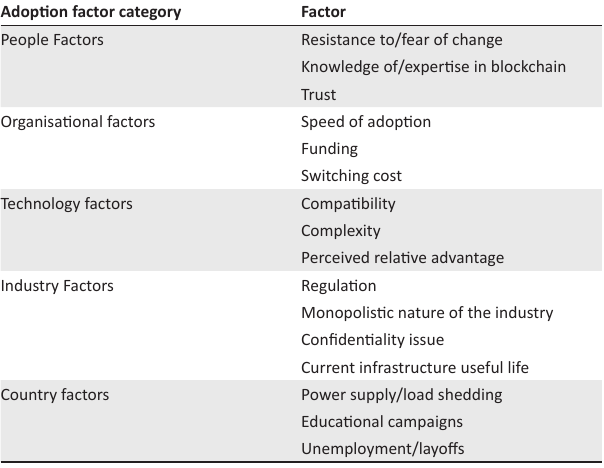
TABLE 3: Theoretical